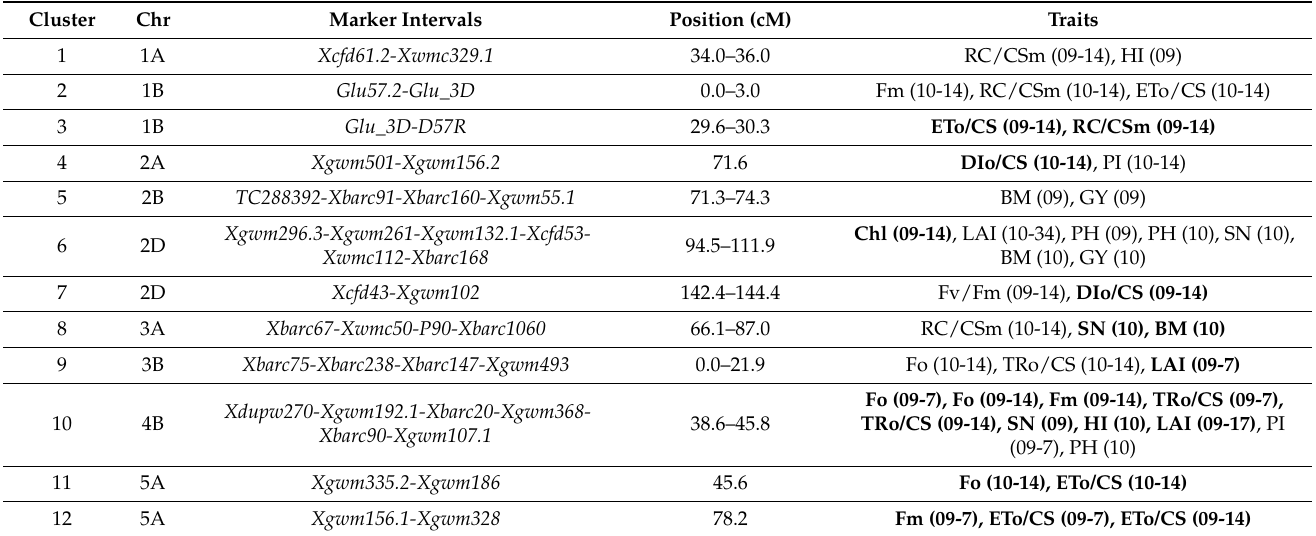
Table 4. QTL clusters detected for at least two of the investigated